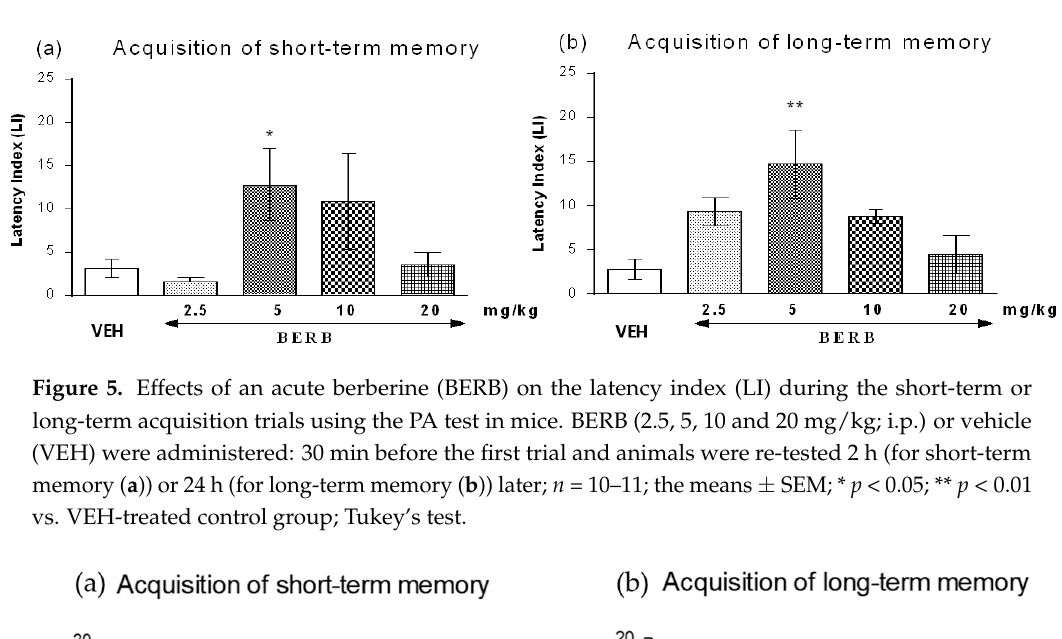
Figure 5. Effects of an acute berberine (BERB) on the latency index (LI) during the short-term or long- term acquisition trials using the PA test in mice. BERB (2.5, 5, 10 and 20 mg/kg; i.p.) or vehicle (VEH) were administered: 30 min before the first trial and animals were re-tested 2h (for short-term memory ( a )) or 24 h (for long-term memory ( b )) later; n = 10–11; the means ± SEM; * p < 0.05; ** p < 0.01 vs. VEH-treated control group; Tukey’s test.